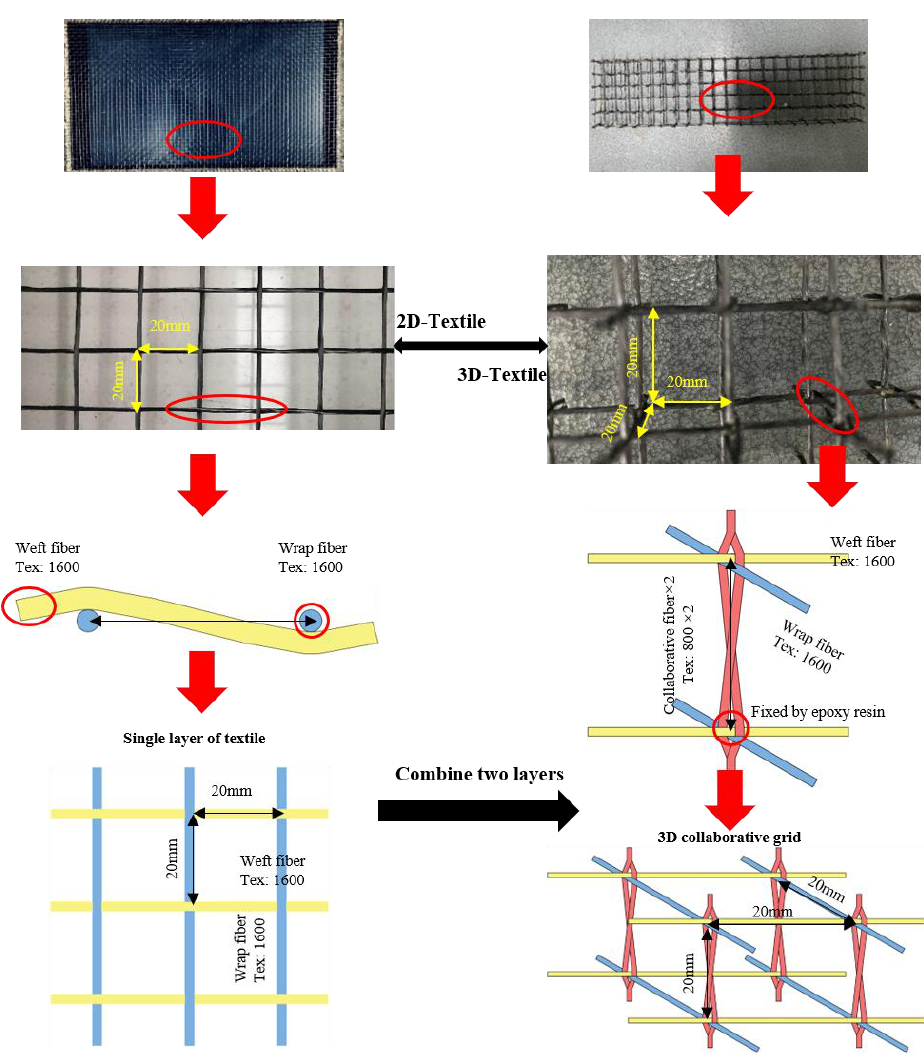
Figure 1. Details of different types of textiles.